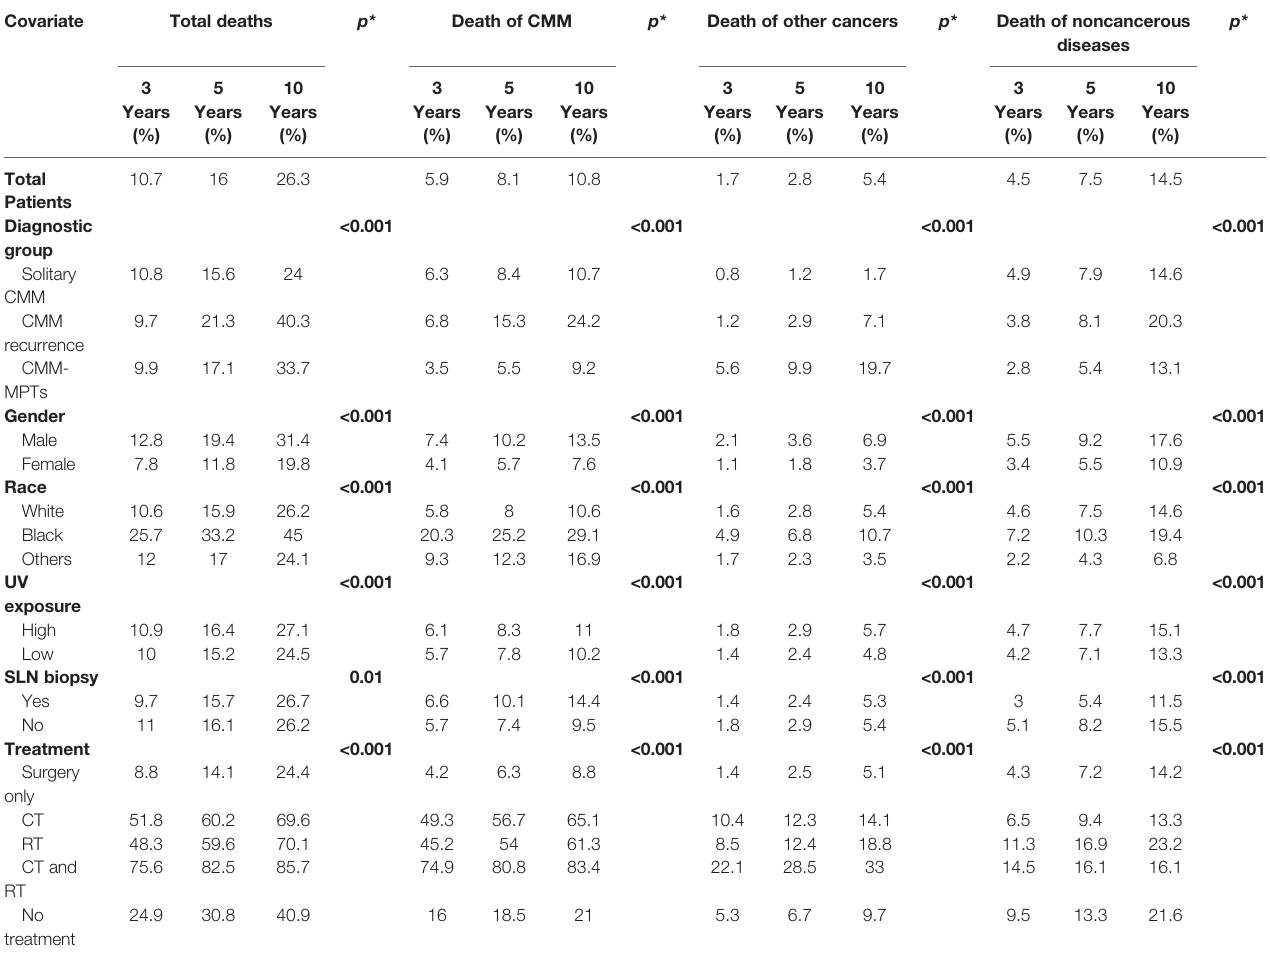
TABLE 2 | Three-, 5-, and 10-year cumulative incidences of cause-speci fi c death among patients with CMM.